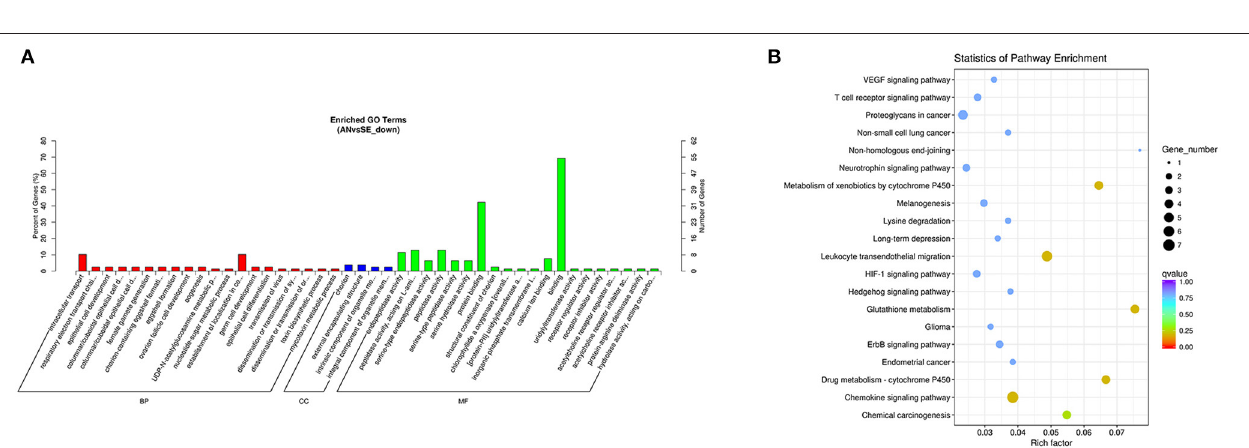
FIGURE 9 | Top annotated GO terms (A) and KEGG pathways (B) of cis-target genes of the downregulated DE lncRNAs.